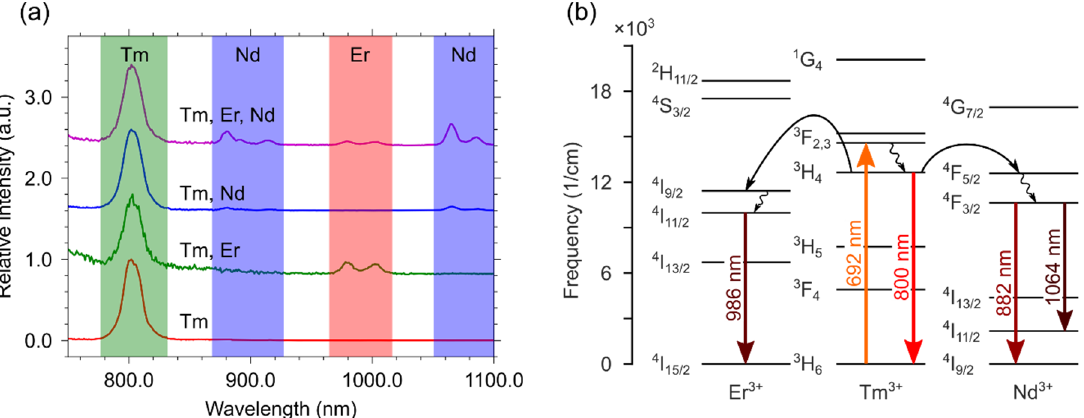
Figure 6. ( a ) Emission spectra and ( b ) scheme of energy migrations between ions for the single-, double-, and triple-doped YVO 4 : Nd 3+ (0.03 at.%), Er 3+ (3 at.%), and Tm 3+ (1 at.%) samples under excitation with λ ex = 692 nm.